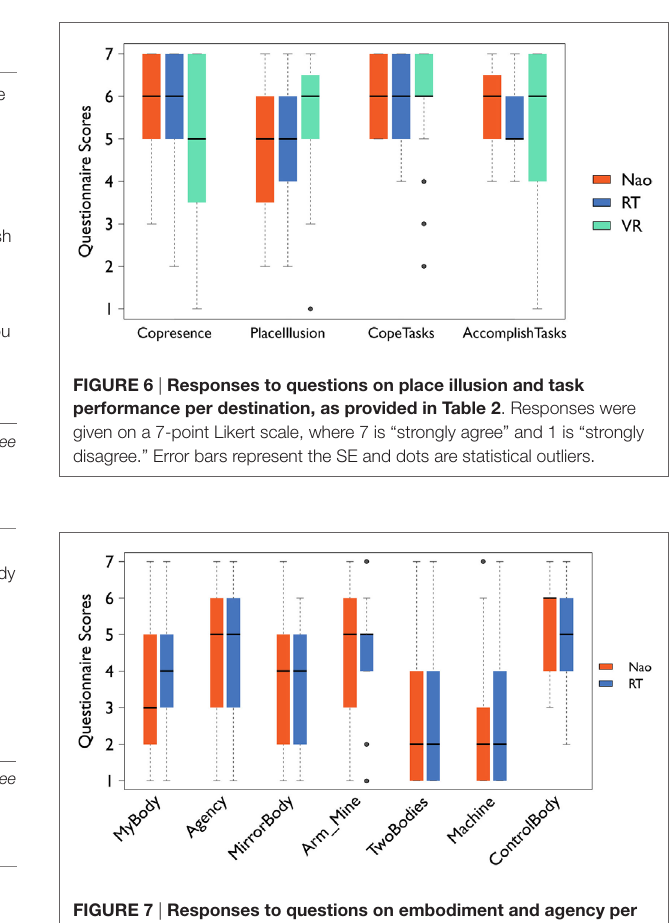
FigUre 7 | responses to questions on embodiment and agency per robot, as provided in Table 1 . Responses were given on a 7-point Likert scale, where 7 is “strongly agree” and 1 is “strongly disagree.” Error bars represent the SE and dots are statistical